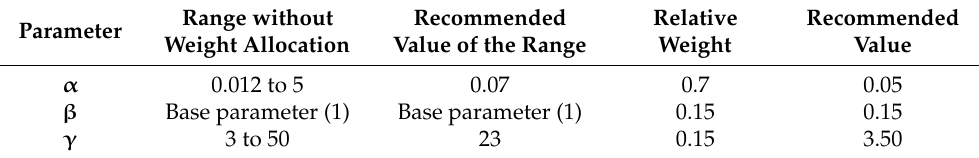
Table 2. Parameter values proposed.